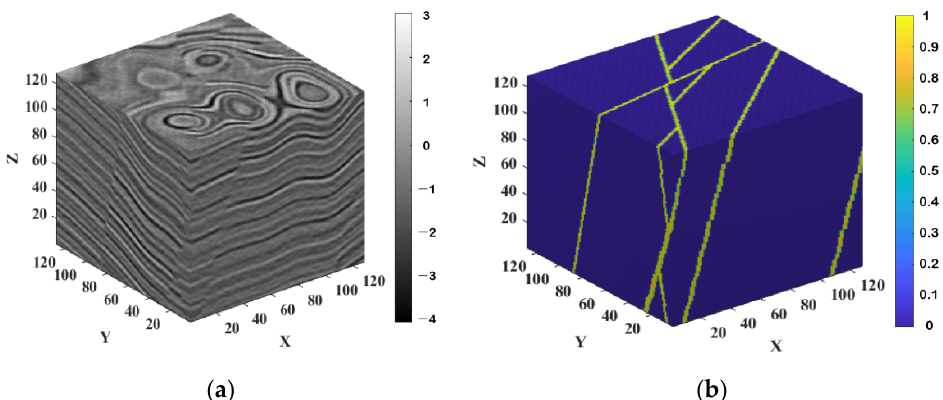
Figure 6. ( a ) A final training seismic data set with the size of 128 × 128 × 128 and ( b ) the corresponding binary fault labeling data set.